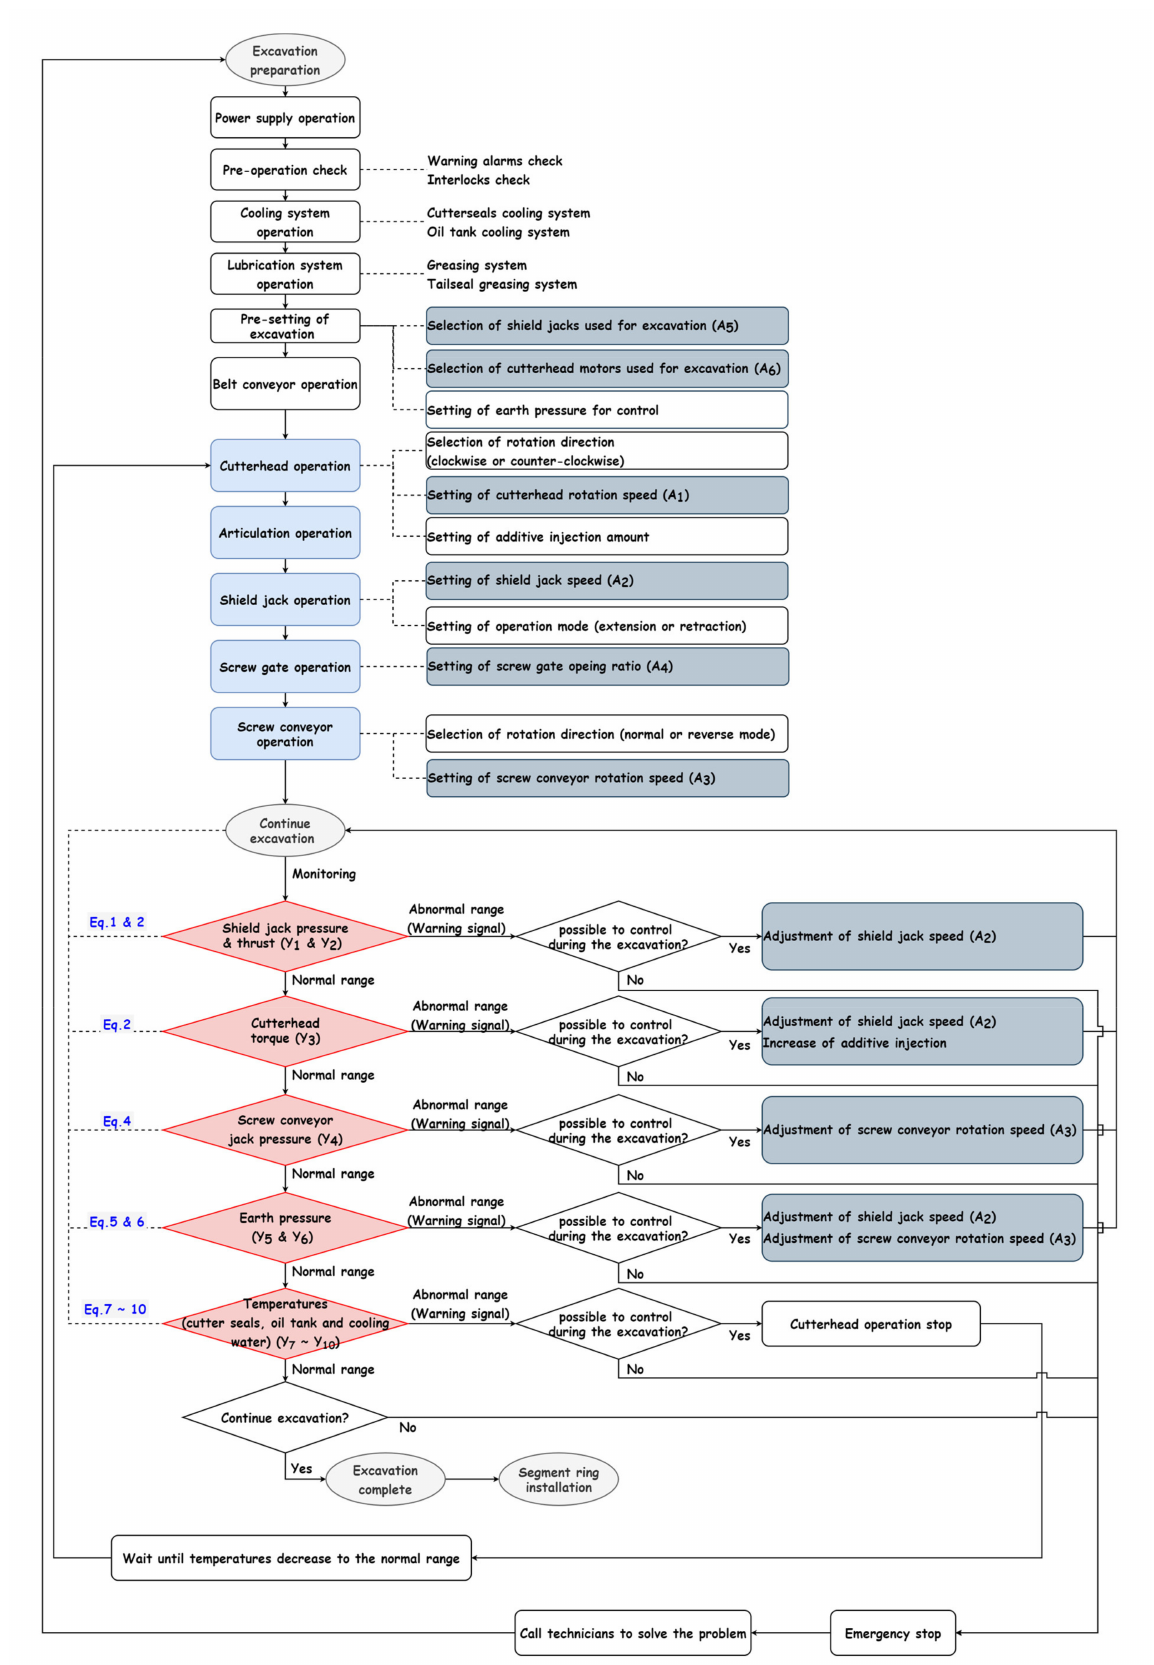
Figure 4. Architecture of excavation procedures applied in the TBM